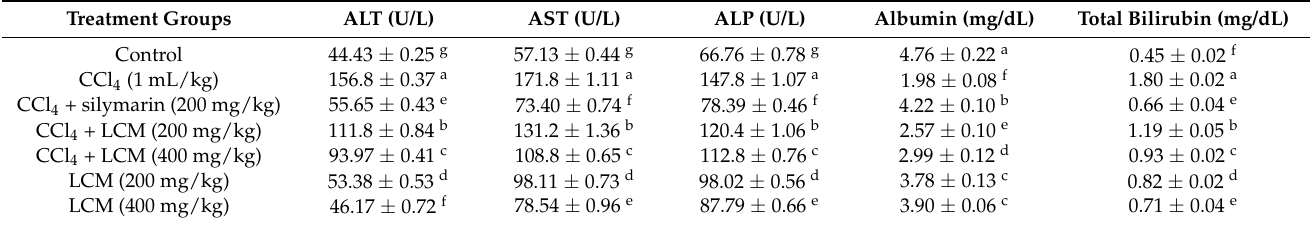
Table 5. Effect of different treatments with L. corymbulosum on liver serum markers.